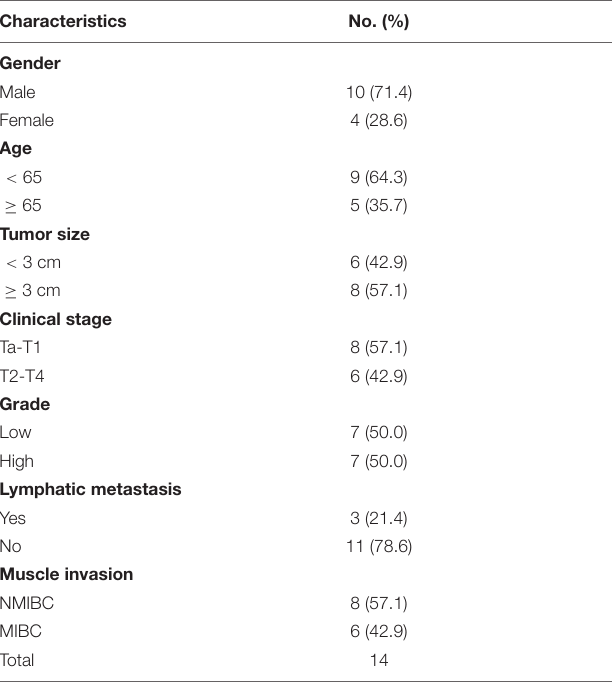
TABLE 3 | Clinicopathological features in 14 pairs of bladder cancer frozen in liquid nitrogen for analysis of ARHGAP isoforms.